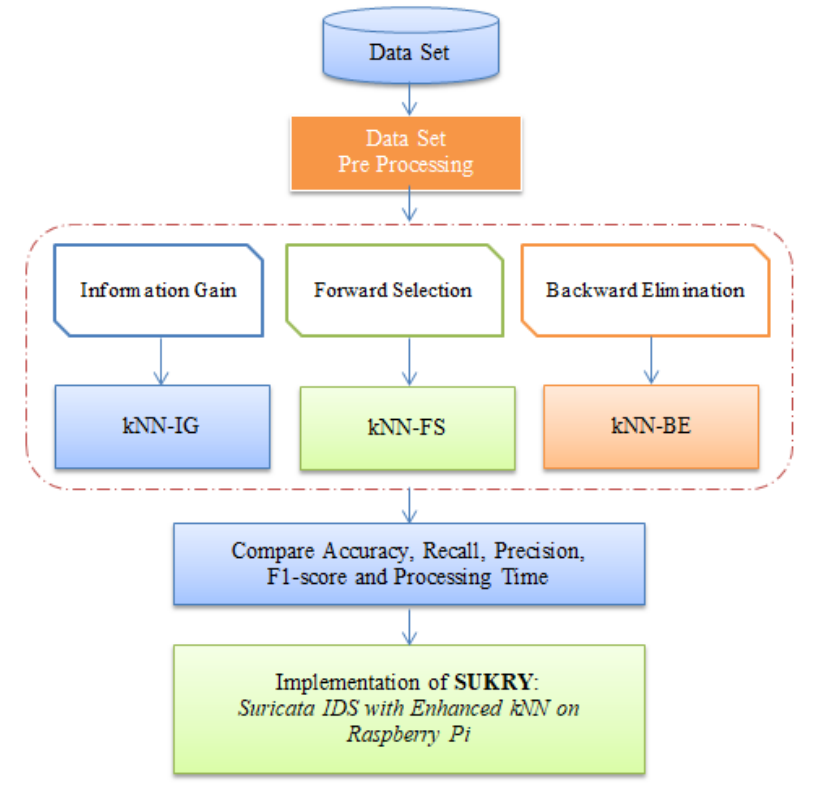
Figure 1. Research Figure 1. Research steps.